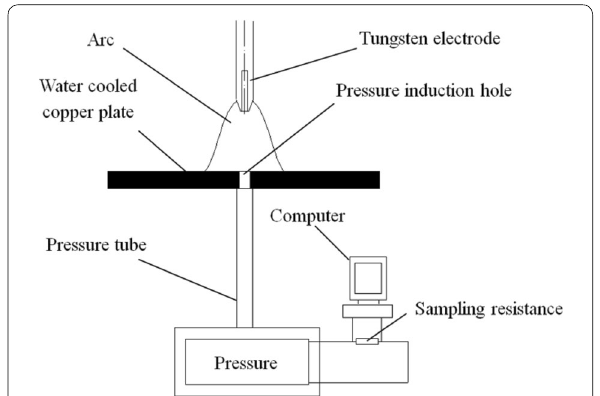
Figure 5 Schematic of arc pressure acquisition